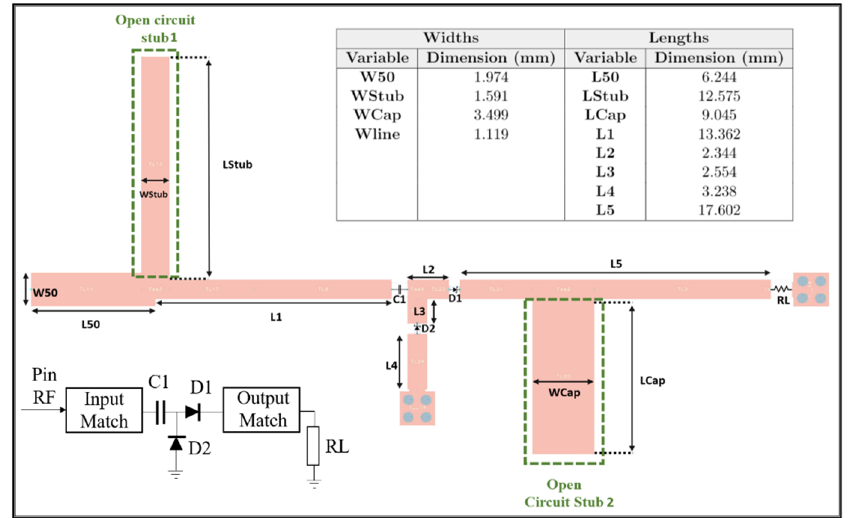
Figure 10. Schematic of the RF–DC converter.